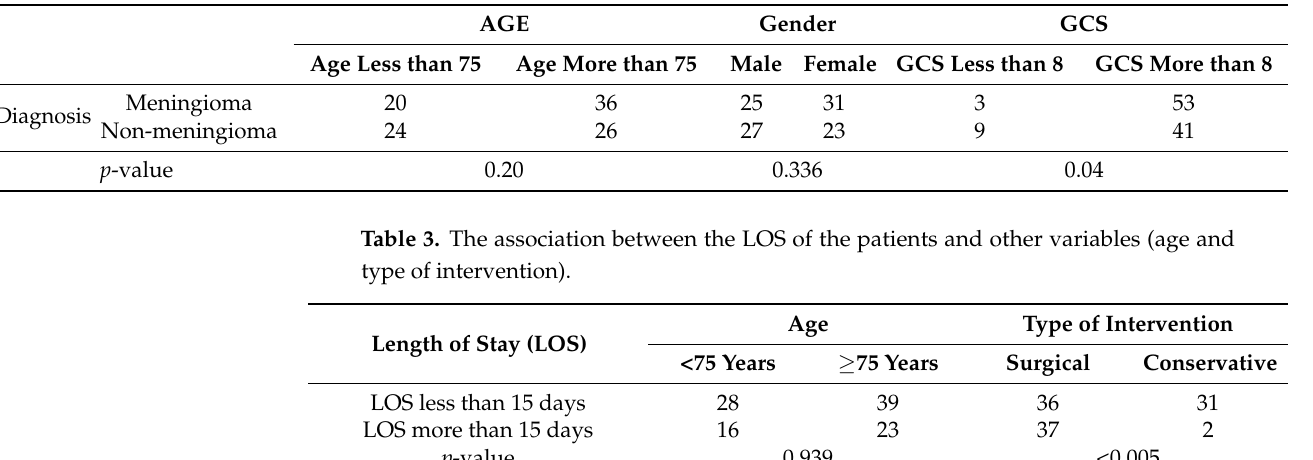
Table 2. The association between the diagnosis of the patients and other variables (age, gender, GCS).